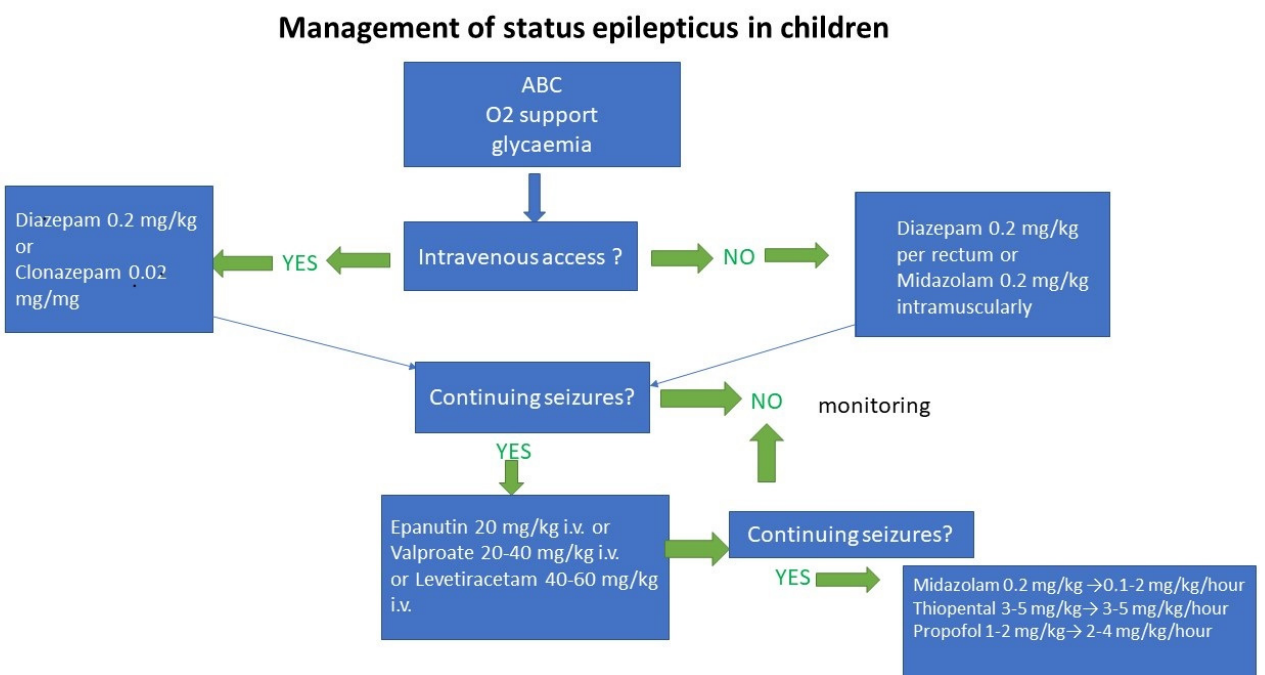
Figure 2. Management of status epilepticus in children.